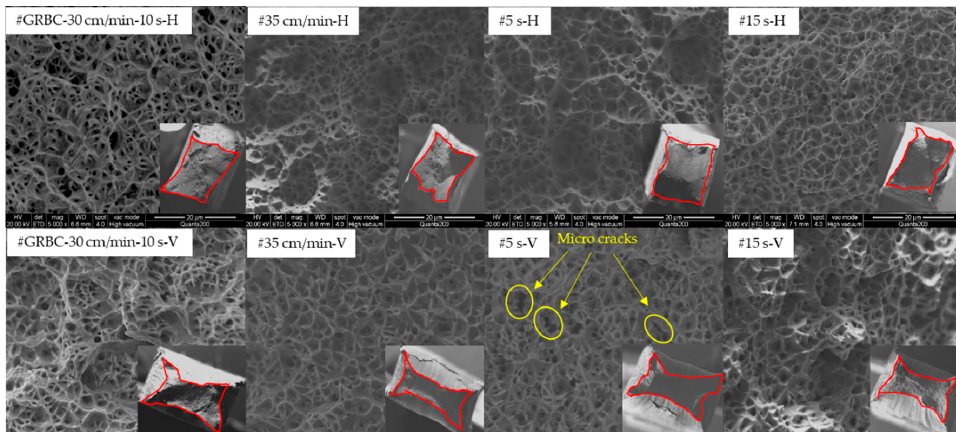
Figure 14. Macroscopic and microscopic fracture surfaces of MIG-AM 316L samples (#GRBC-30 cm/min-10 s-H and #GRBC-30 cm/min-10 s-V represent the horizontal and vertical tensile fracture surfaces of sample #GRBC-30 cm/min-10 s, respectively). (TRBC and GRBC represent transient and gradual reduction of bottom current,